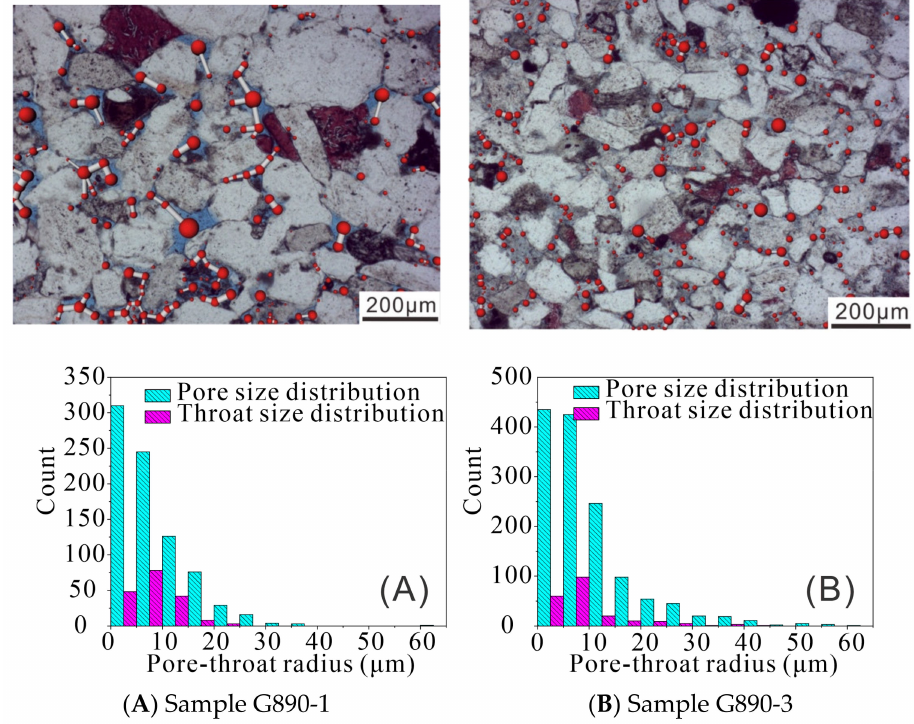
Figure 13. Two-dimensional (2D) pore network model and pore throat size distribution derived from photomicrograph